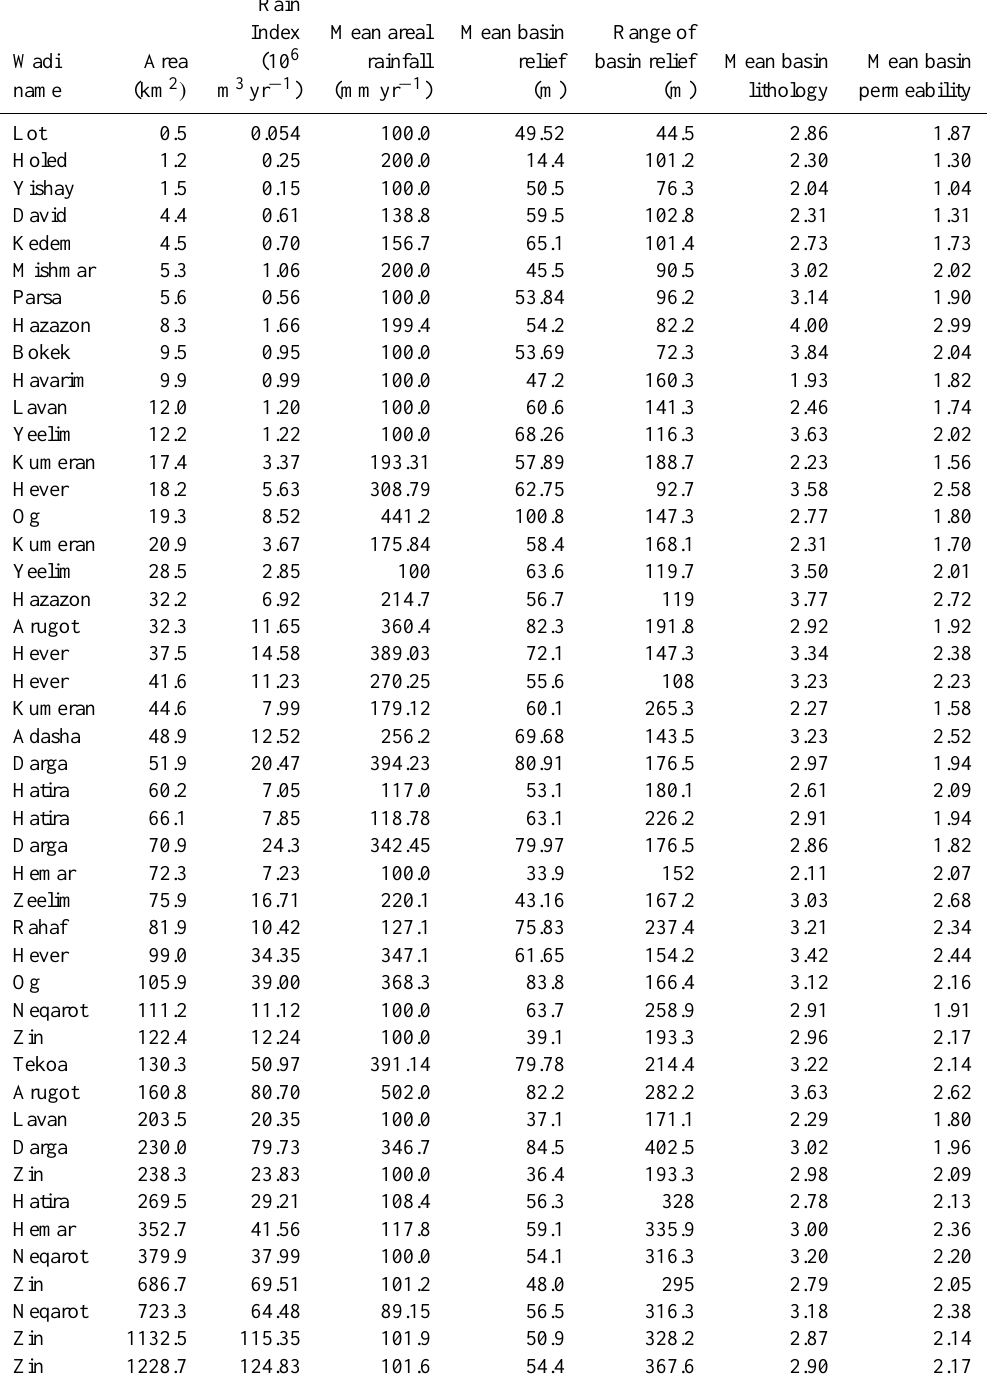
Table A1. Basin characteristics as described in Sect. 6. Rain Index Mean areal Mean basin Range of Wadi rainfall relief basin relief Mean basin Mean